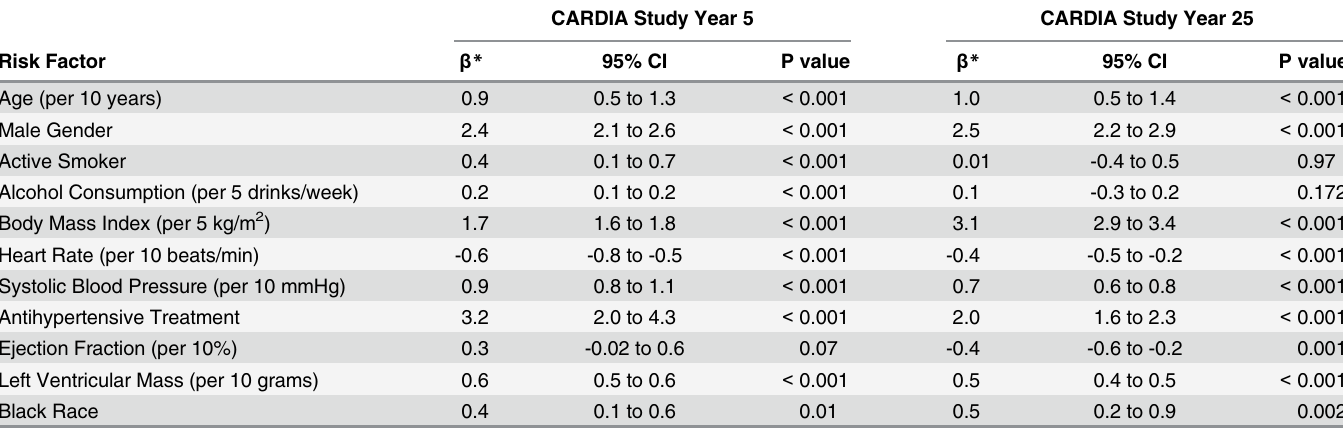
Table 2. Unadjusted Association Between Traditional Risk Factors and Left Atrial